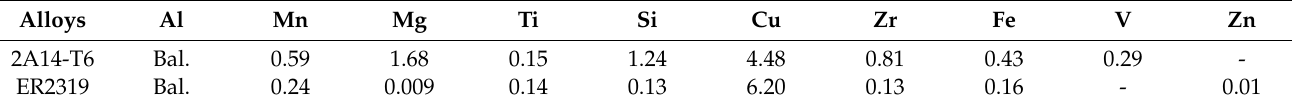
Table 1. Chemical compositions of 2A14 aluminum alloy and ER2319 filler metal (wt. %).